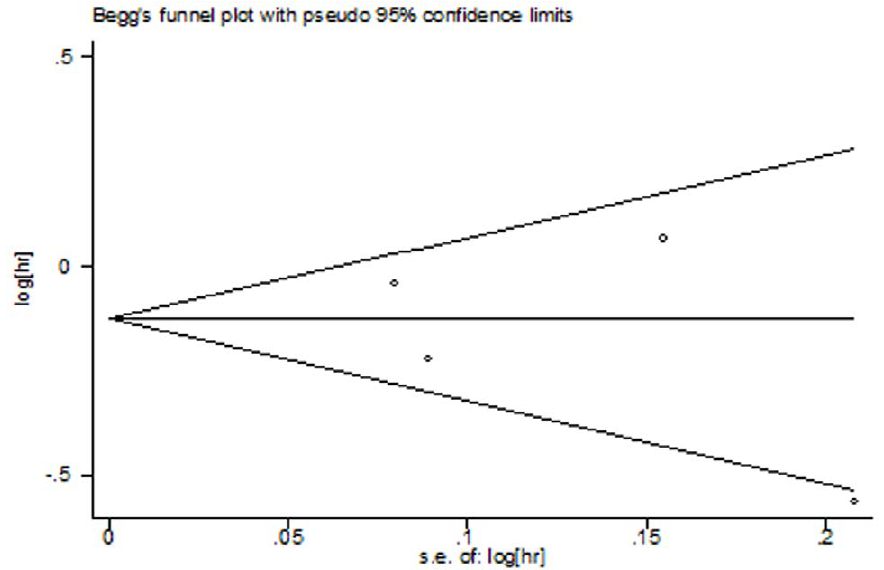
Figure 8. Funnel plot for publication bias test of PFS. The two oblique lines indicate the pseudo 95% confidence limits.